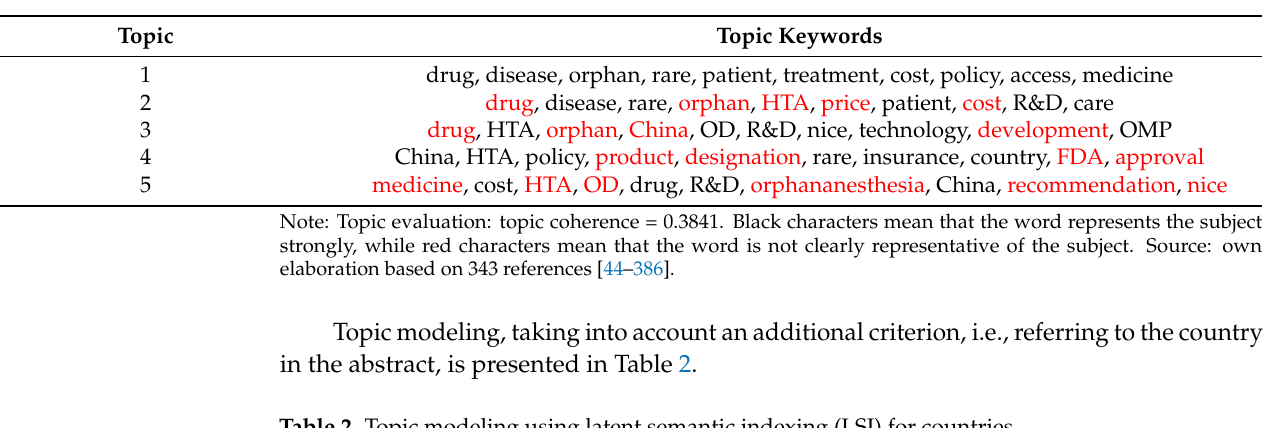
Table 1. Topic modeling using latent semantic indexing (LSI).